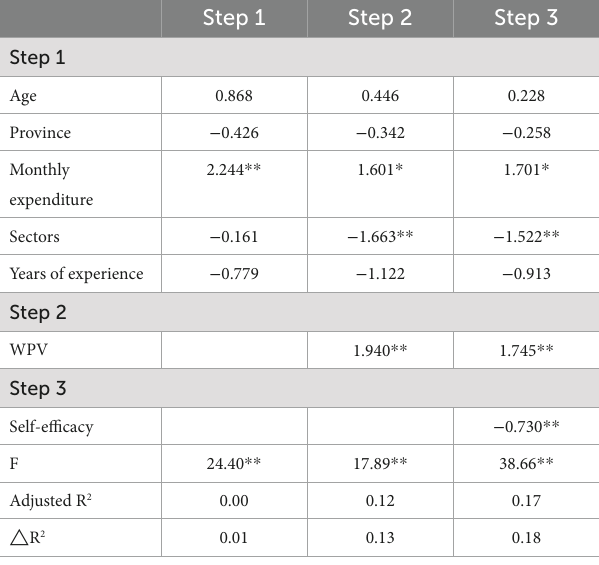
TABLE 3 Hierarchical multiple regression analysis results for PTSD.